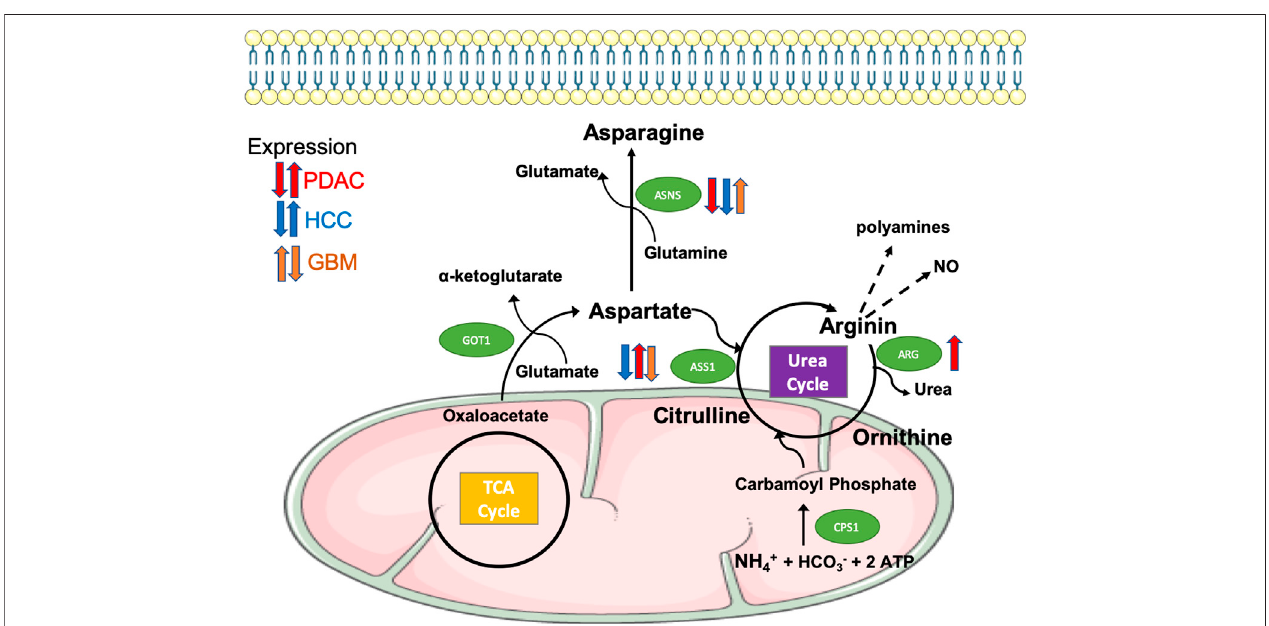
FIGURE 2 | Differential expression of enzymes regulating the biosynthesis and metabolism of asparagine and arginine in aggressive tumours. The amino acid aspartate is synthesised from oxaloacetate, a TCA cycle intermediate, and from glutamate via the transaminase GOT1. Aspartate is then used in the biosynthesis of asparaginemediatedbytheenzymeASNS(Asparaginesynthetase),enterstheureacycletocontributetothesynthesisofarginineviaASS1(argininosuccinatesynthase 1),orcanprovideitsaminogroupasfreeammoniathatbuildscarbamoylphosphate viaCPS1,thusinitiatingtheureacycle.ArginineisfurthermetabolisedbyARG (arginase, isoforms 1 and 2) to produce urea and ornithine, thus completing the urea cycle, or to polyamines and nitric oxide, both of them implicated in cancer cell aggressiveness through chromatin remodelling and cell signalling. As indicated, the expression of ASNS, ASS1 and ARG is differentially dysregulated in PDAC (red arrows), HCC (blue arrows) and GBM (orange